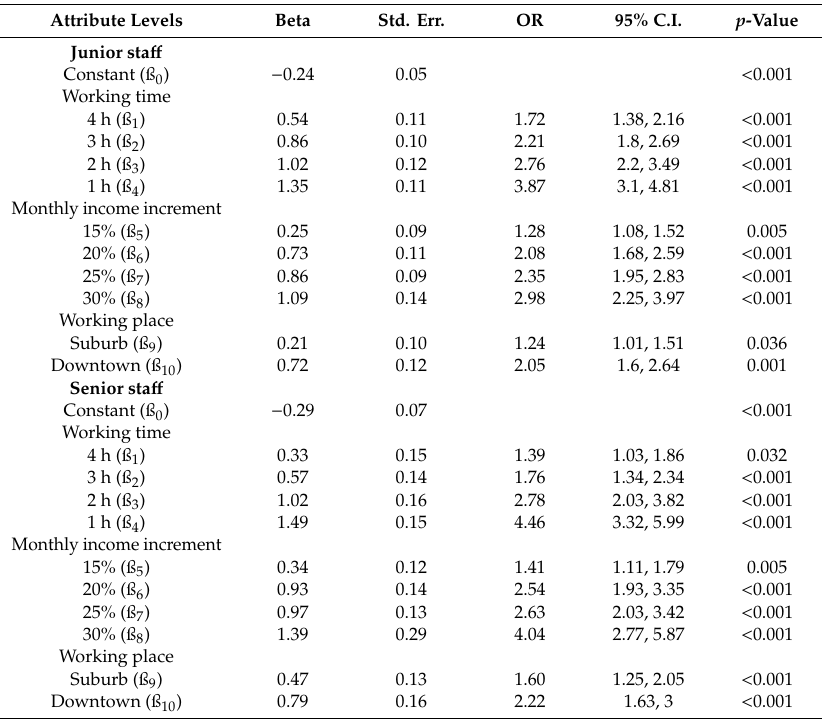
Table 7. Sub-group e ff ect model stratified by professional